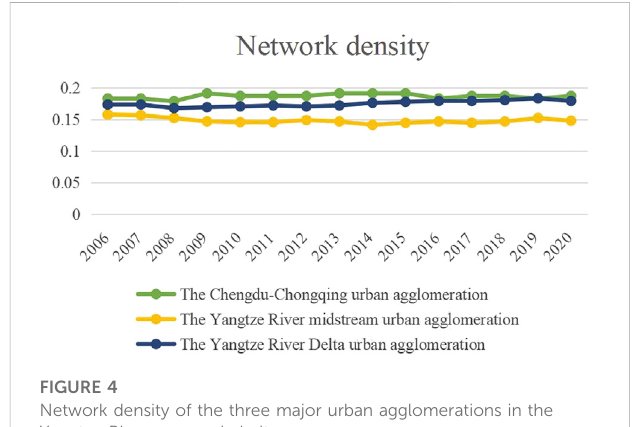
FIGURE 4 Network density of the three major urban agglomerations in the Yangtze River economic